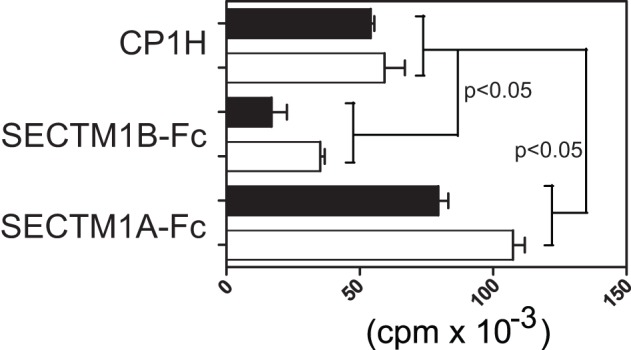
Modulation of T cell proliferation by SECTM1A and SECTM1B occurs independently of CD7.Proliferation assay with C57BL/6 (black bars) and CD7−/− (white bars) CD4+ T cells cultured on 2C11 coated plates in the presence of 10 μg solid-phase mSECTM1A-Fc fusion protein or SECTM1B-Fc. Proliferation was measured at 48 hours. Results representative of five separate experiments. Statistical significance determined by Student's t test.